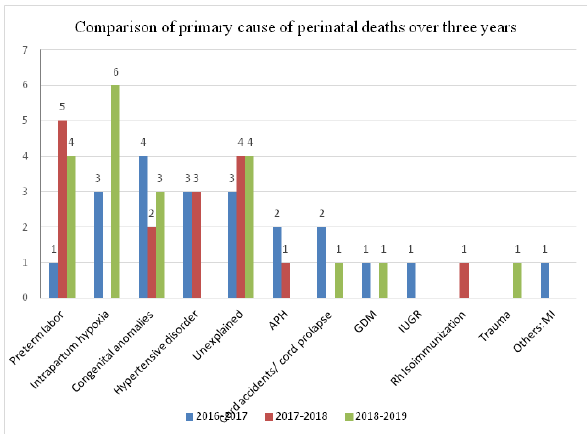
Figure 2 Comparison of primary cause of perinatal deaths over three years Table 3 shows the causes of perinatal death using Wigglesworth’s classification, in the year 2018-19, 2017-18, and 2016-17. Among all groups of Wiggleworth's classification, group IV was the most common in the fiscal year 2016-17 and group III and IV in